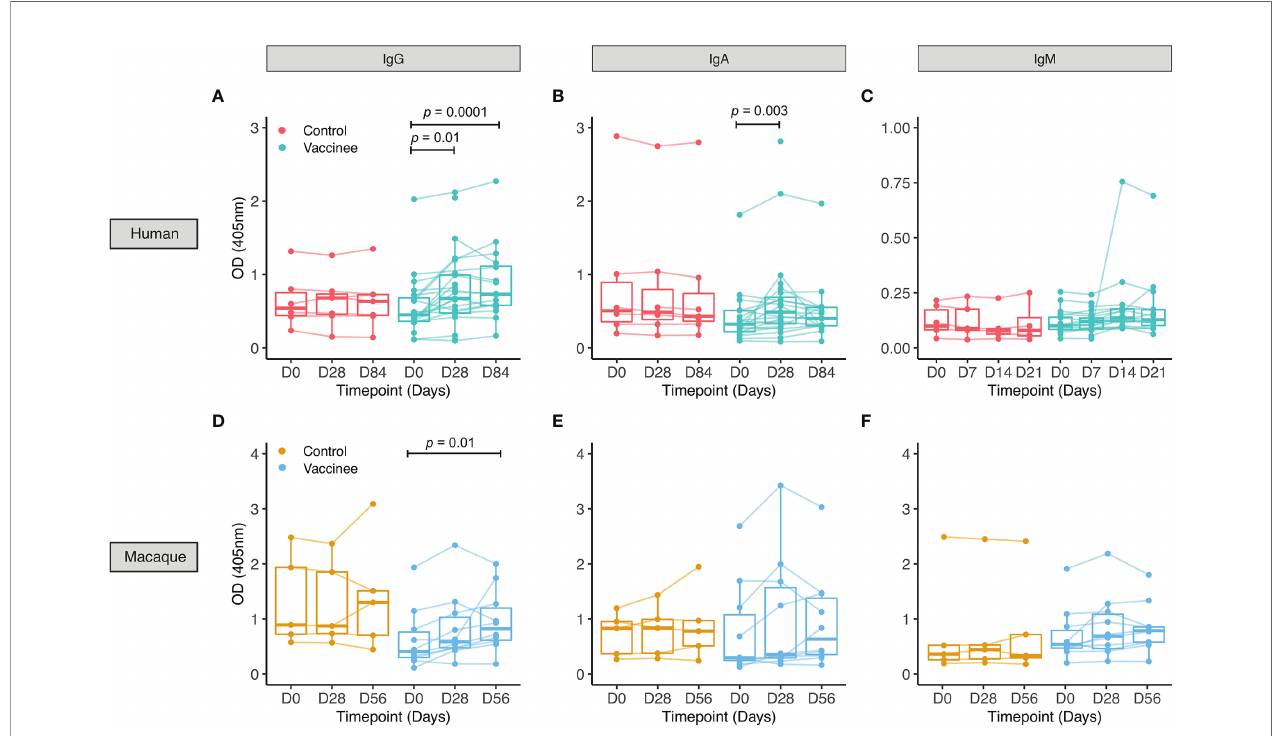
FIGURE 1 | PPD-speci fi c antibodyresponses to BCG vaccination in healthy UK adults andrhesusmacaques. Serum was collected from volunteersenrolled into human Study 1 whowereeither unvaccinatedcontrols(red) or received BCG vaccination (cyan) (A – C) , and from rhesusmacaques enrolledinto macaque Study 1 which were either unvaccinatedcontrols(yellow) or received BCG vaccination (blue) (D – F) . PPD-speci fi c IgG (A,D) , IgA (B, E) and IgM (C, F) responses were measured over time. Points represent the mean of triplicate values, boxes indicate the median value with the interquartile range (IQR) and the upper whisker extends to the largest value nofurther than 1.5 * IQR from the hinge, the lower whisker extends from thehinge to the smallest value at most 1.5 * IQR from the hinge. Outliersare plottedindividually.A mixed effects analysiswith Dunnett ’ s correction for multiplecomparisonswas conductedonlogged values (A – C) ora Friedman test with Dunn ’ s correction for multiple comparisons (D – F) was performed to compare the BCG vaccine-inducedresponse between post-vaccination and baseline